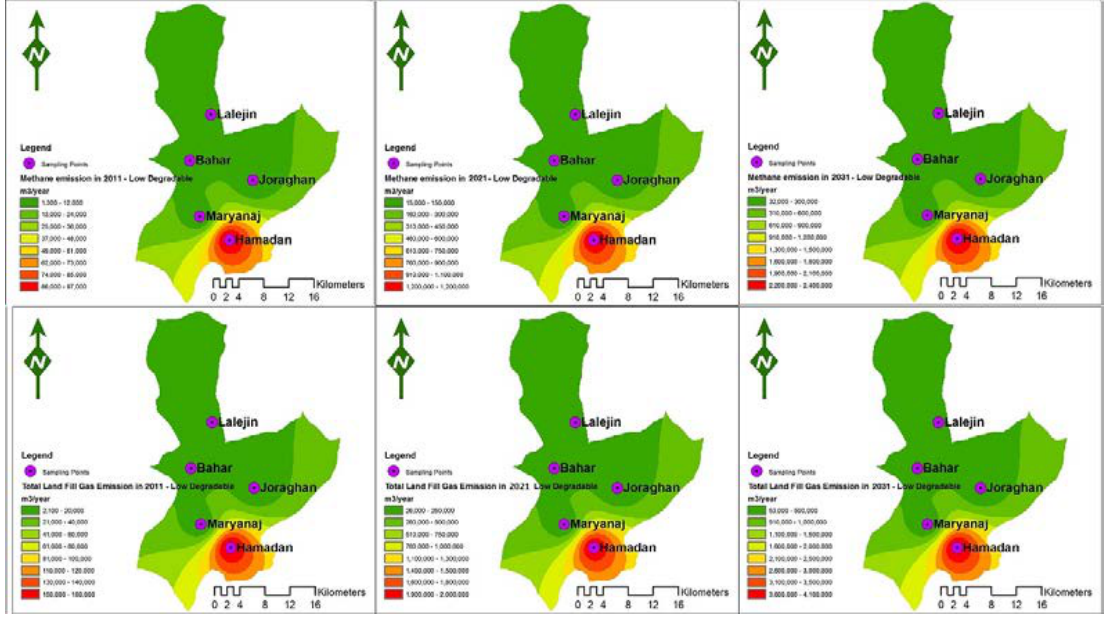
Fig. 9: Spatial distribution of slowly degradable organic compound, methane and total landfill gas emission in two decades (2011-2021 and 2021- 2031) in the study area